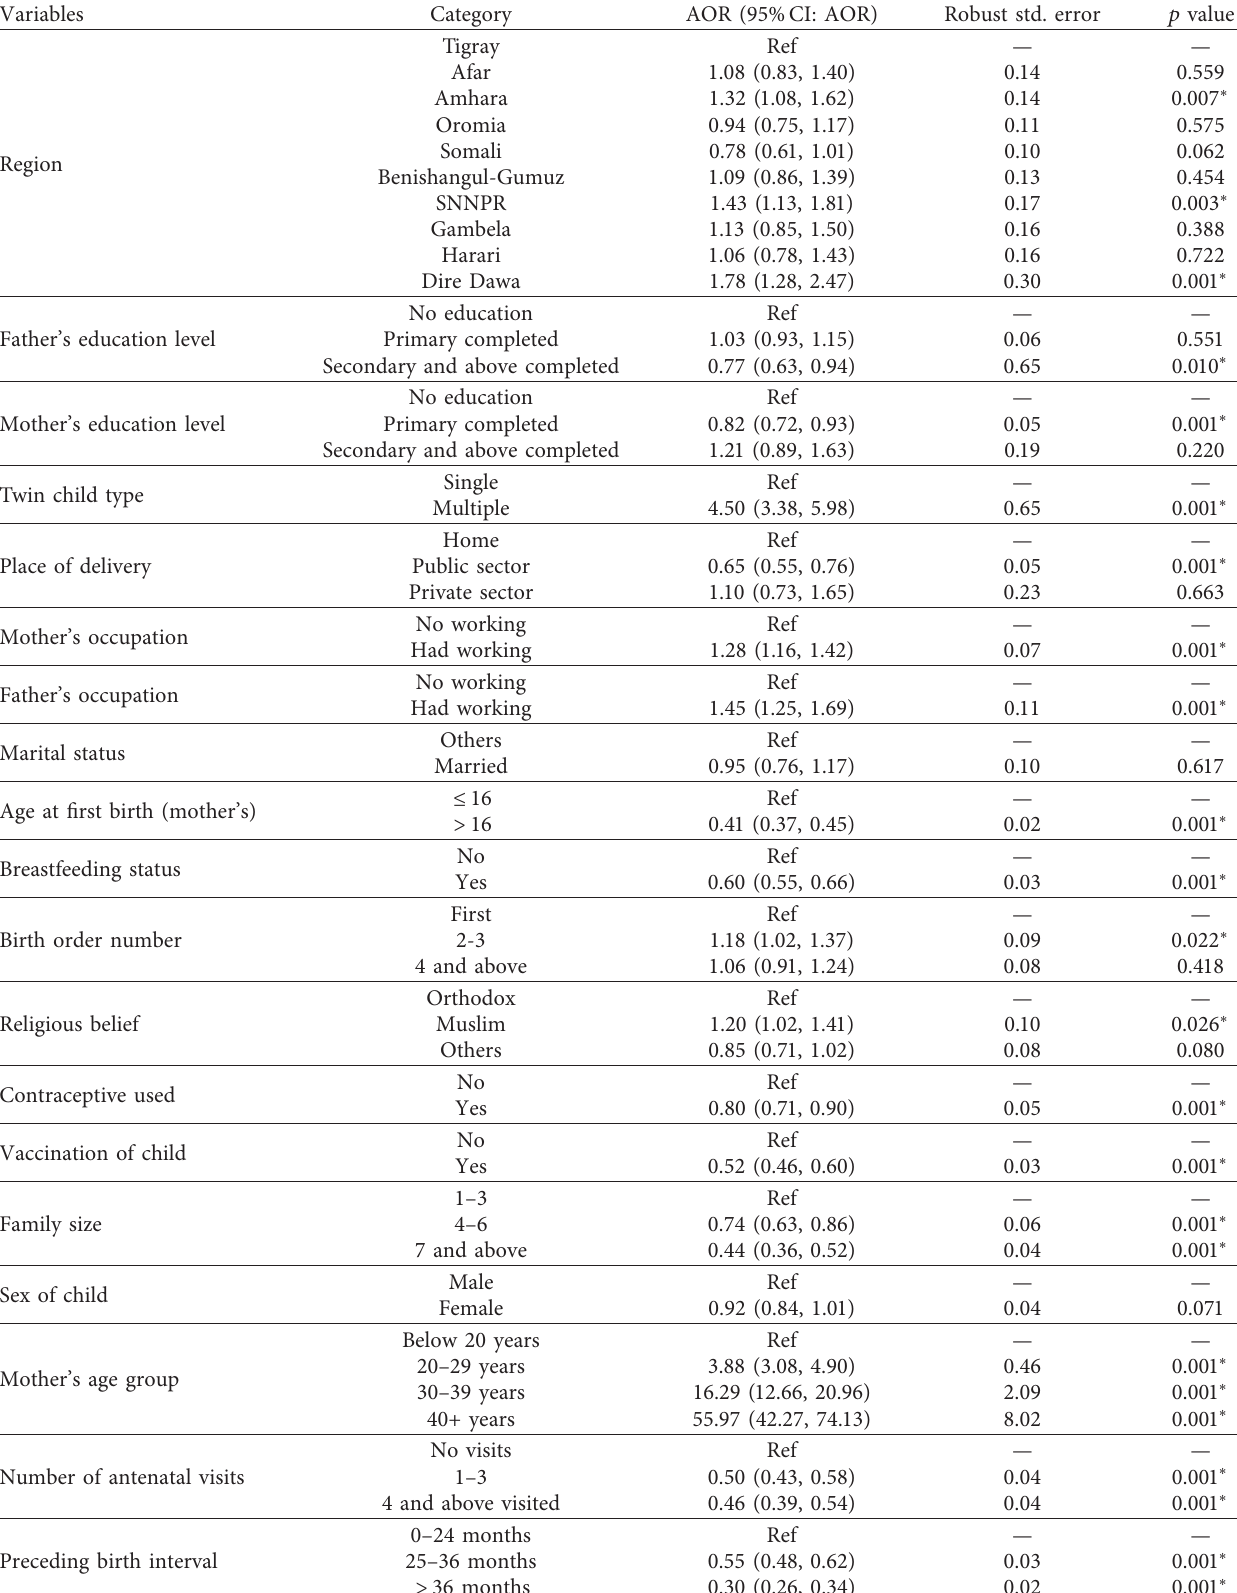
Table 17: Binary logistic analysis of under-five mortality (multivariable analyses): rural